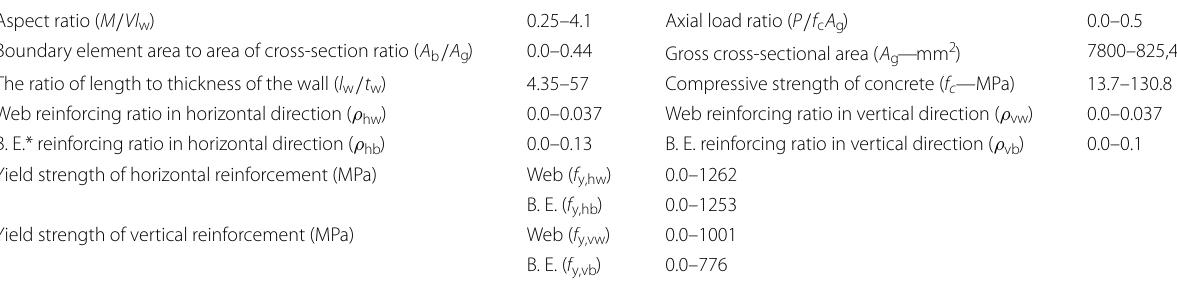
Table 2 Statistical features of database.